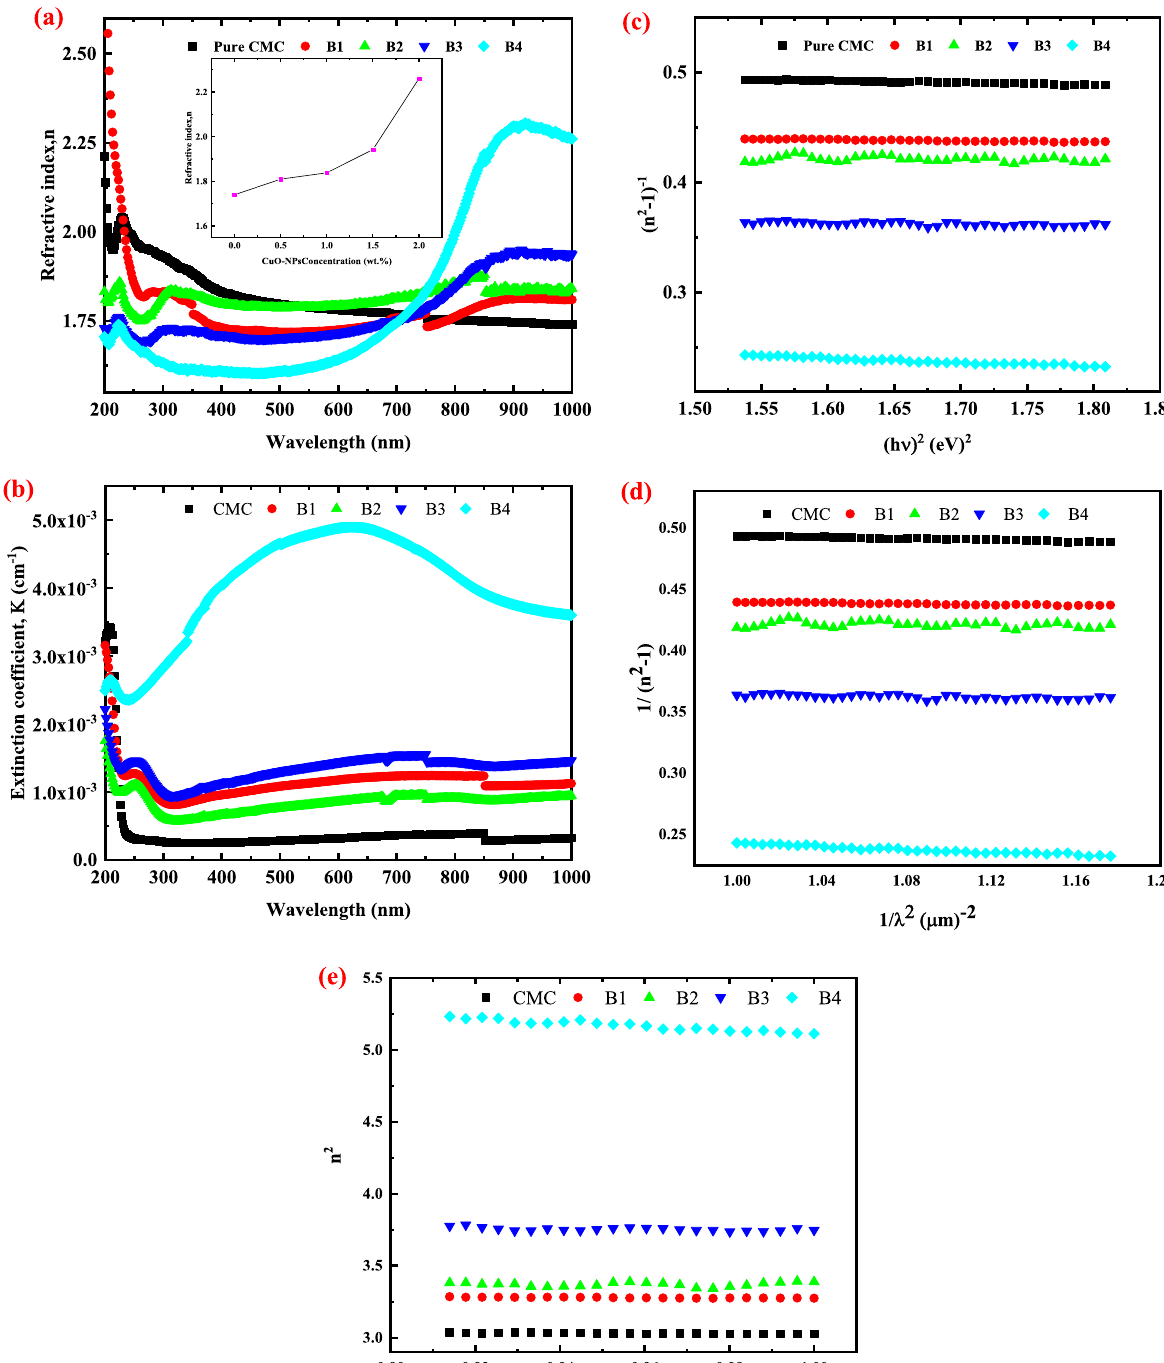
Figure 8. ( a ) Wavelength dependent refractive index (n) with the variation of n with CuO-NPs concentration (inset of the figure) ( b ) variation of extinction coefficient with the wavelength for CMC and CMC with different CuO-NPs concentration ( c ) the plot of 1/(n 2 -1) versus (hν) 2 ( d ) 1/(n 2 -1) versus λ -2 and ( e ) n 2 versus λ 2 of pristine CMC and CuO-NPs filled CMC nanocomposite